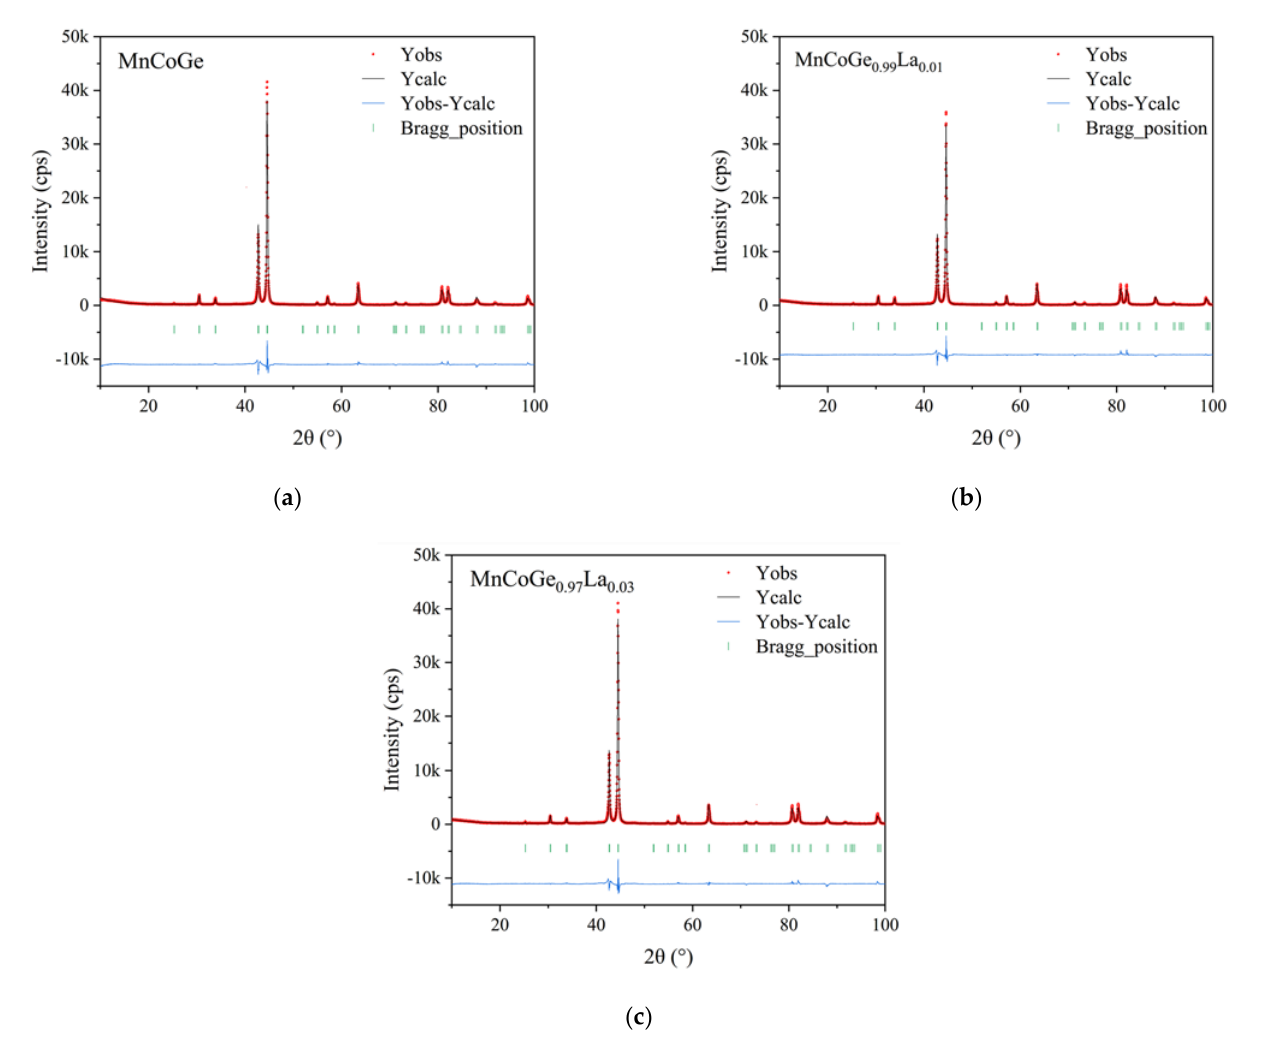
Figure 3. Rietveld refinement results for MnCoGe 1 − x La x. : ( a ) MnCoGe; ( b ) MnCoGe 0.99 La 0.01 ; ( c ) MnCoGe 0.97 La 0.03 . Table 1. Rietveld refinement result for MnCoGe 1 − x La x series